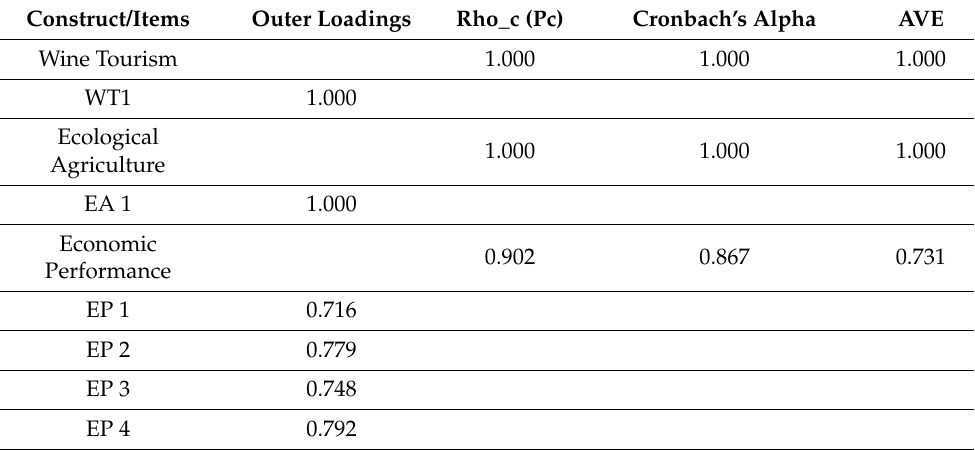
Table 3. Measurement model analysis: external loadings, construct reliability, and convergent